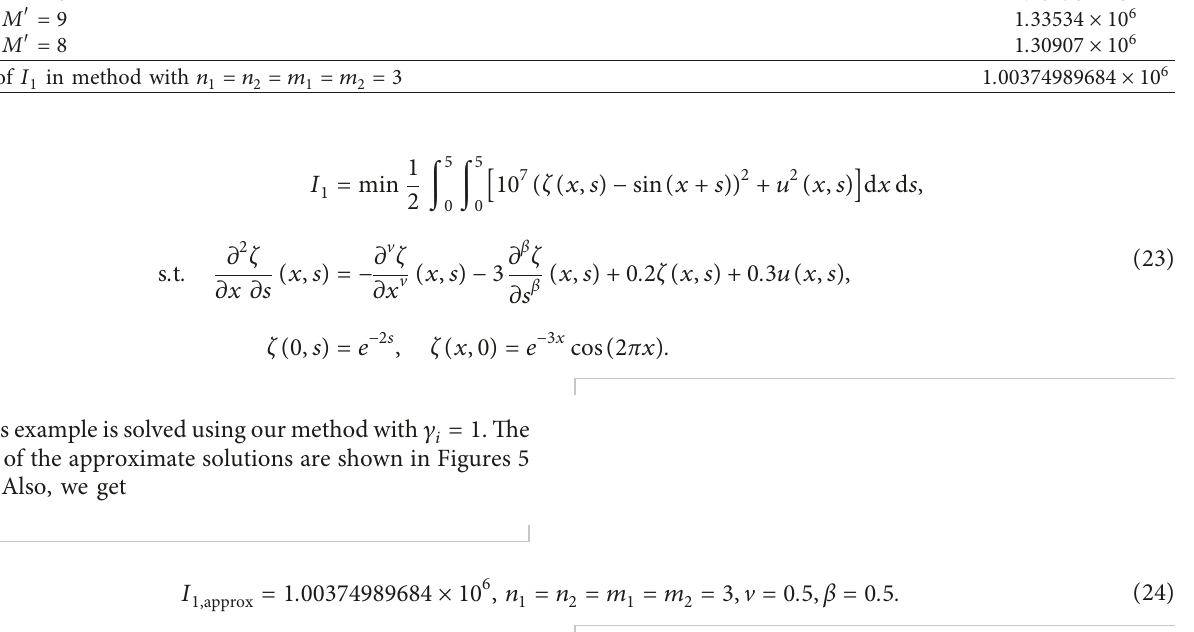
x,s n m m with n 1 2 (cid:29) 1 (cid:29) 2 (cid:29) 3 for Example 2. ( ) (cid:29) 1 in some references.